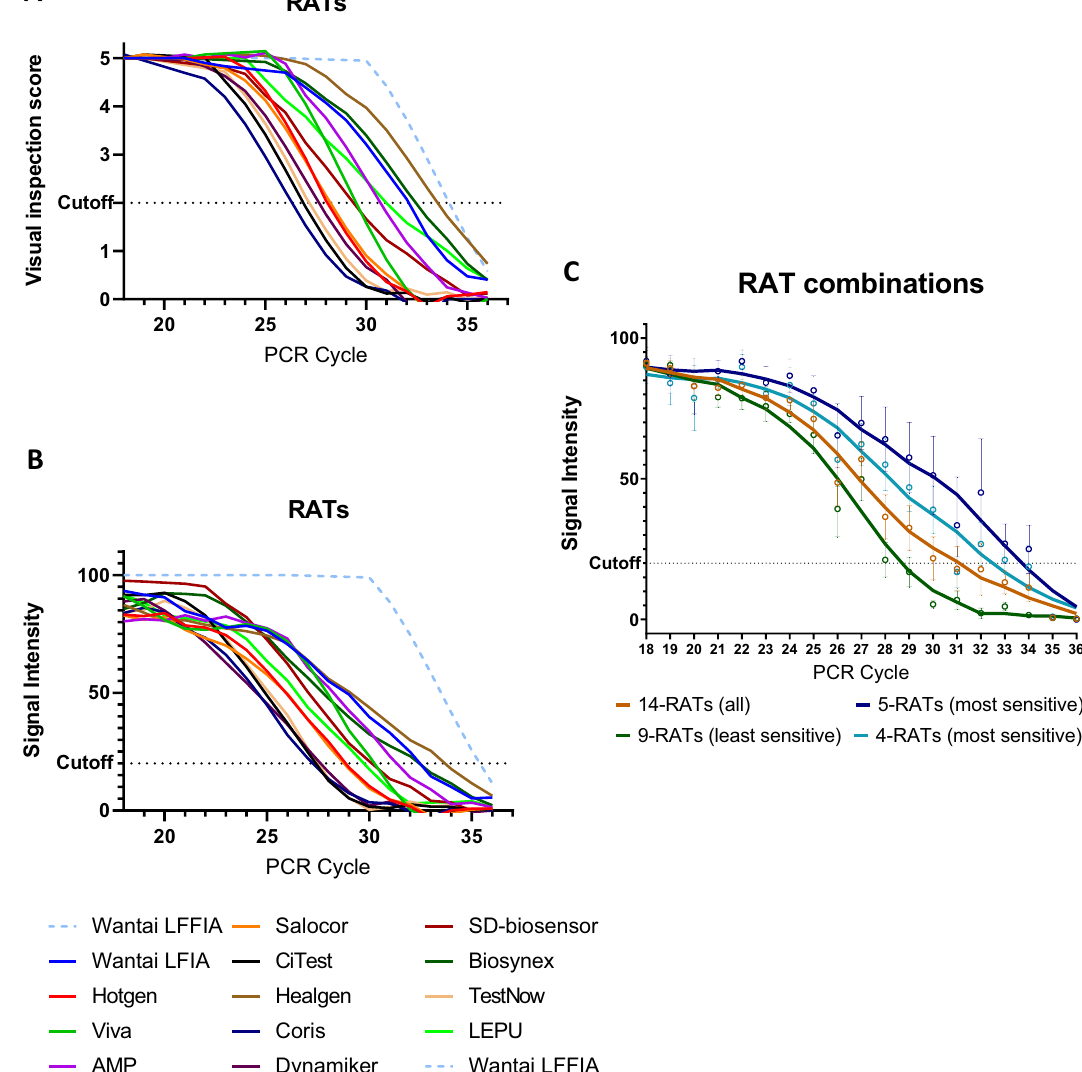
Figure 2. ( A ) A reverse correlation of the visual inspection score of the band with the PCR cT was found (Pearson’s r = − 0.704, p < 0.0001). The cutoff value of each RAT was determined as the average cT that produces a test band with at least a score of 2 in the optical observation (which can be surely visually observed). ( B ) A reverse correlation of the colorimetric intensity of the band with the PCR cT was found (Pearson’s r = − 0.733, p < 0.0001). The cutoff value of each RAT was determined as the average cT that produces a test band with an intensity of 20% compared to the control band. The detection limit varied between cT = 27.2 and cT = 33.6 amongst conventional individual LFIA/VFIA assays and was found at cT = 35.3 for the fluorescence LFFIA assay. Especially for the LFFIA assay, positive samples were considered to have an intensity of 100 and negative samples an intensity of 0, due to the lack of quantitative data. ( C ) RAT combinations. Overall, the detection limit of the 14 RATs tested was cT = 31.1. The best 5 (most sensitive) RATs, including the LFFIA assay, showed a detection limit of cT = 33.7 and excluding the fluorescence LFFIA assay (4 top) had a detection limit of ct = 32.5. On the other hand, the 9 less sensitive RATs showed a significantly lower detection limit of cT= (for samples with cT ≤ 30 and cT ≤ 33) to 99.1% and 90,9%, respectively, ratios ensuring correct identification of people currently transmitting virus. The 100% specificity found in our study may represent the lower number of the evaluated normal samples (50 evaluations) than the number of the evaluated positive samples (400). The percentage of false positive samples in RAT testing in the literature is about 1% or less. Thus, with 50 evaluated normal samples it is possible not to meet this number. Since we used RATs of many different manufacturers and focused on the determination of the limit of detection (LOD) for each RAT, it was necessary to evaluate a large number of positive samples. The sensitivity found in our study, as categorized in different cT ranges, is in full concordance with previous studies that evaluated individual RATs with regard to the cT values of the samples 20,21 . If we do not consider the cT value, the sensitivity rates found (74.3%) are not directly comparable to these of other reports, since we